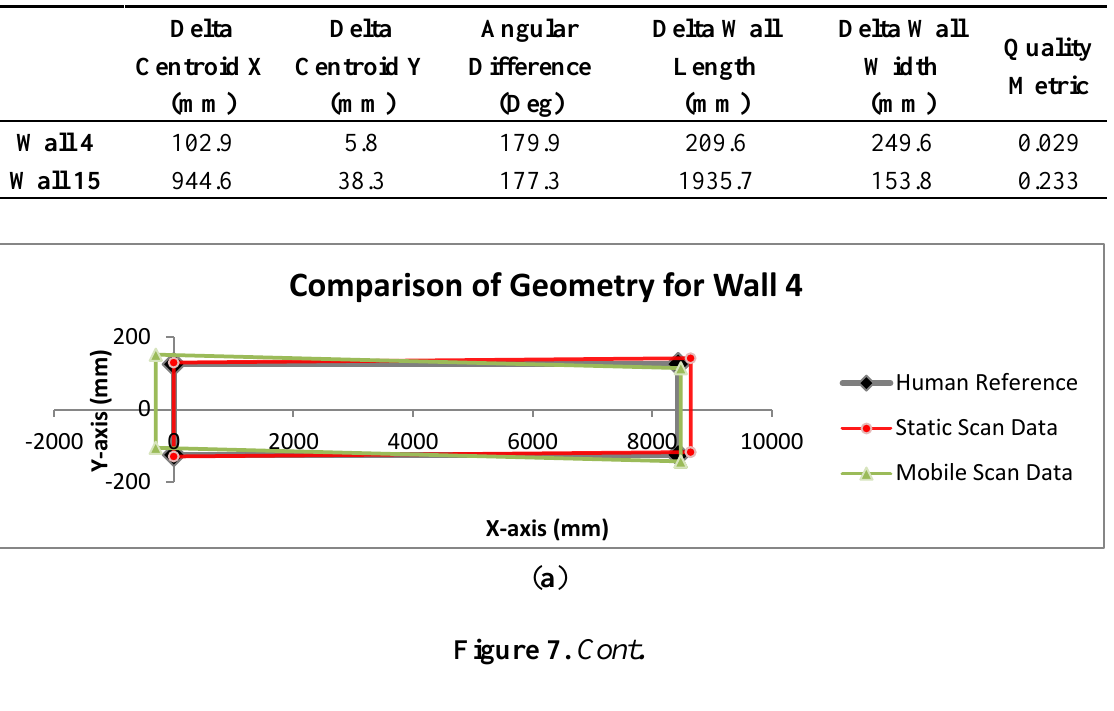
Table 1. Example of data from a wall comparison with quality metric for a well (wall 4) and poorly (wall 15) reconstructed case of the corridor dataset against the static scan derived geometry.